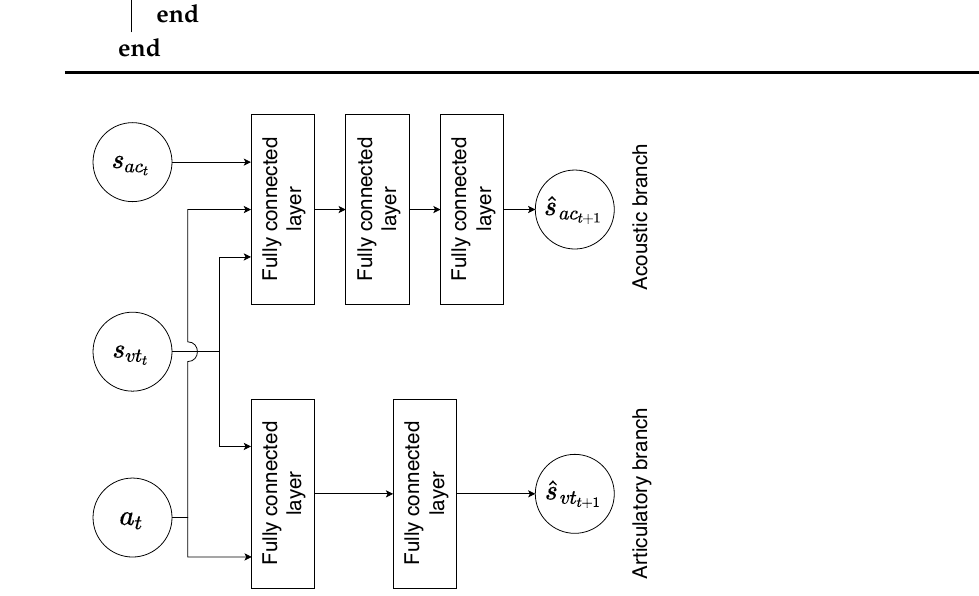
Figure 5. Structure of the forward-model neural network with two separate branches. The acoustic branch has three stacked fully connected layers with 512, 256, and 16 units respectively, where the output of the last layer is a 16-dimensional vector that matches the dimension of the acoustic state. The acoustic branch receives both articulatory s vt